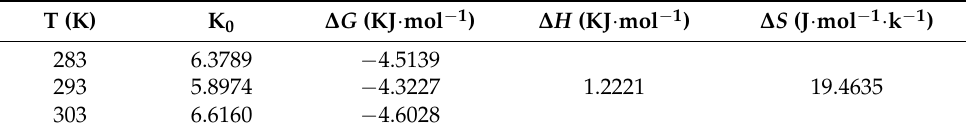
Table 4. Thermodynamic parameters for the adsorption of Cu(II) ions on MXCS/PAA.